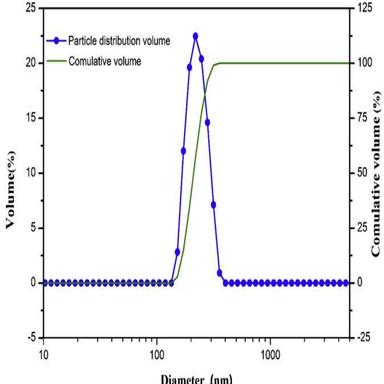
Particle size distribution of CsxWO3 nanoparticles.